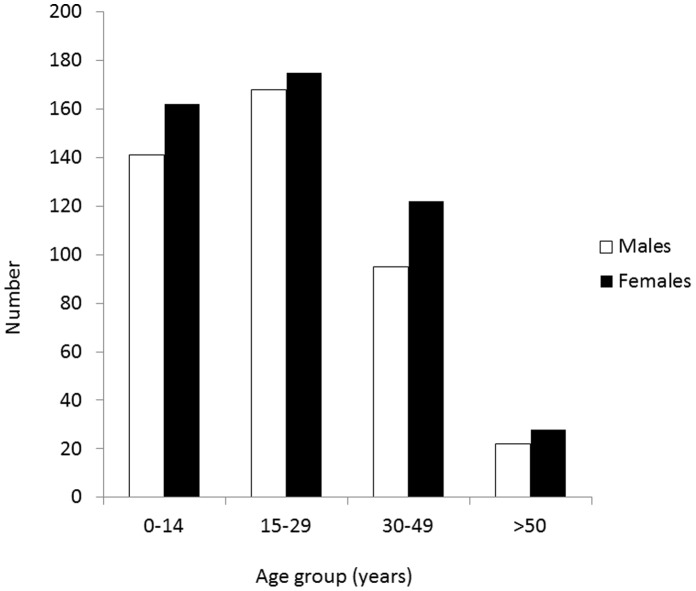
Age and gender distribution of newly arrived refugees who participated in the study (n = 916).